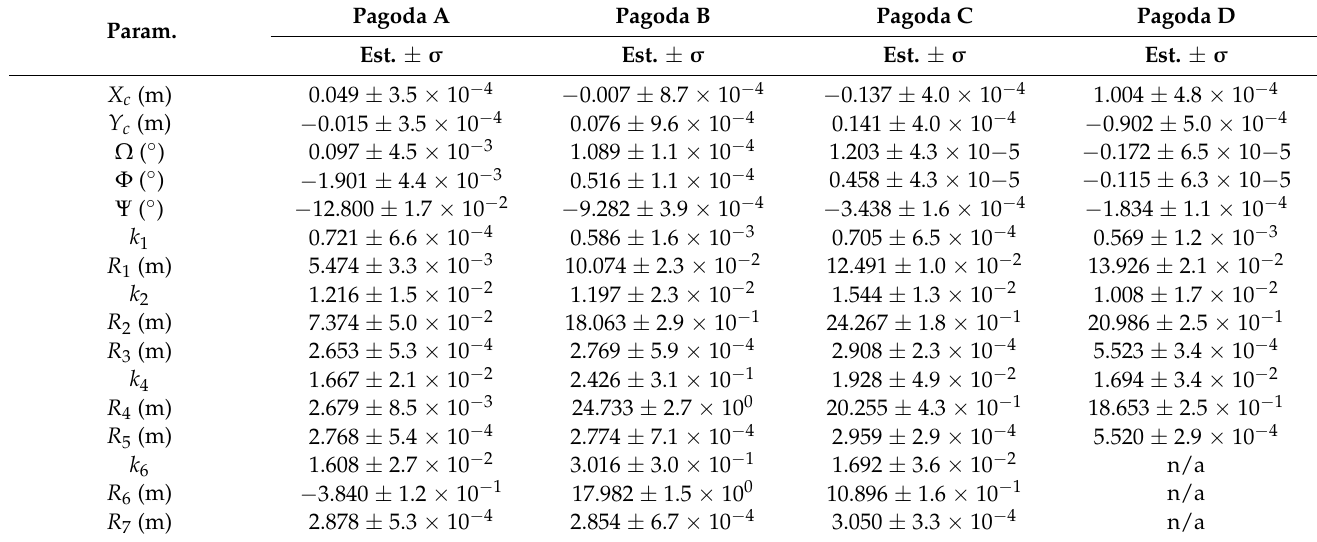
Table 5. Estimated parameters and their precisions of fittings of the proposed model for entire pagoda.